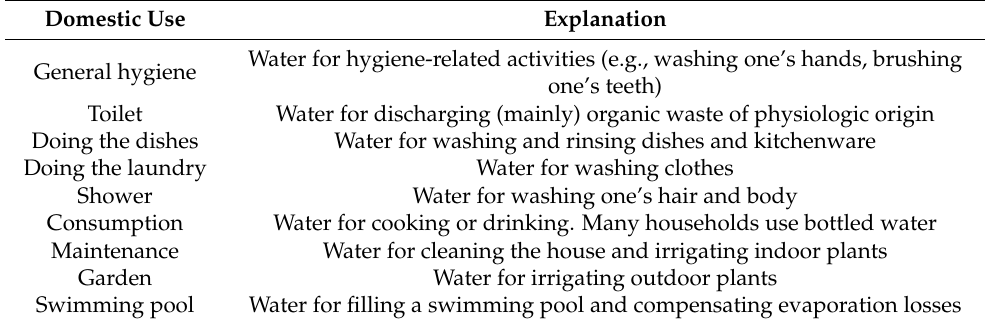
Table 2. Main water domestic uses.